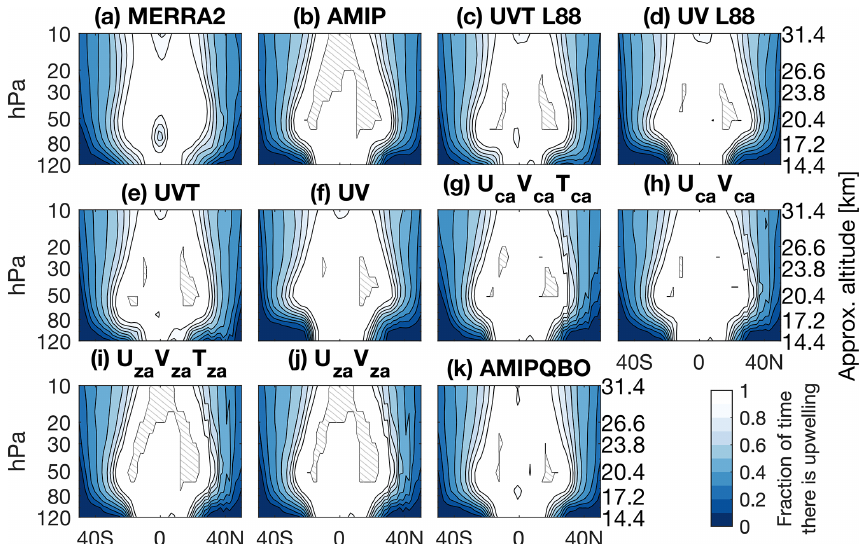
Figure 2. Frequency of upwelling based on the streamfunction definition of the residual circulation for each model simulation. Hatching indicates there is upwelling 100% of the